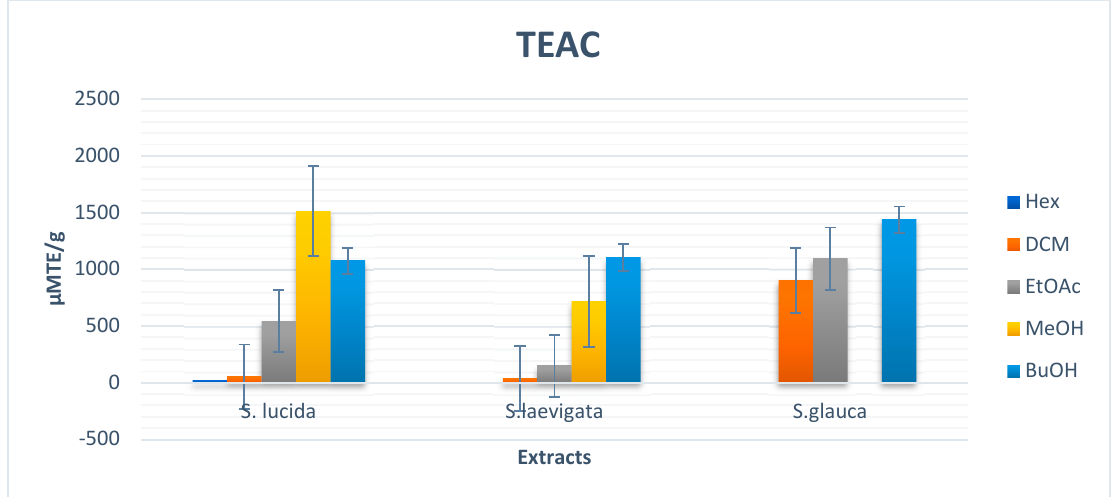
Figure 4. Bar chart of TEAC values of extracts from S. lucida, S. laevigata, and S. glauca.